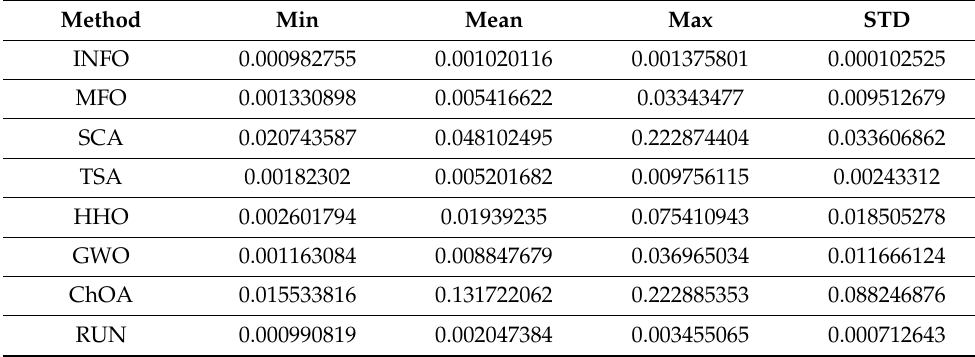
Table 7. Statistical results for the DDMSC.